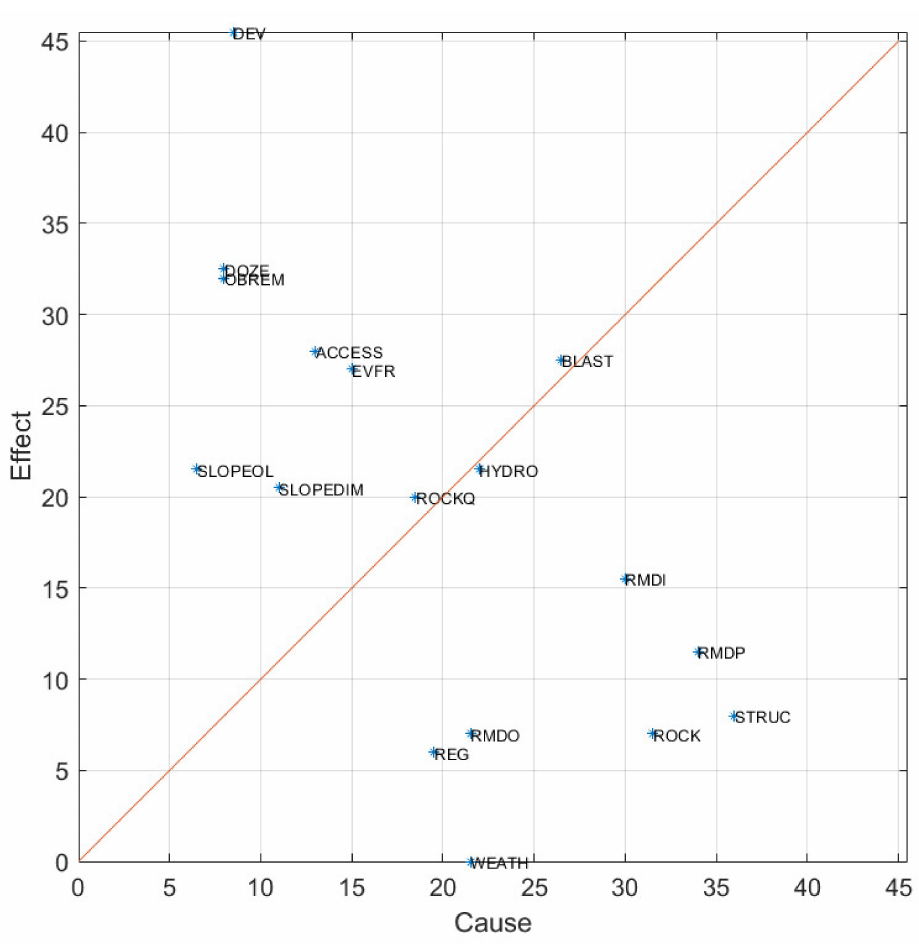
Figure 8. Cause-effect plot based on the BIM presented in Figure 7.